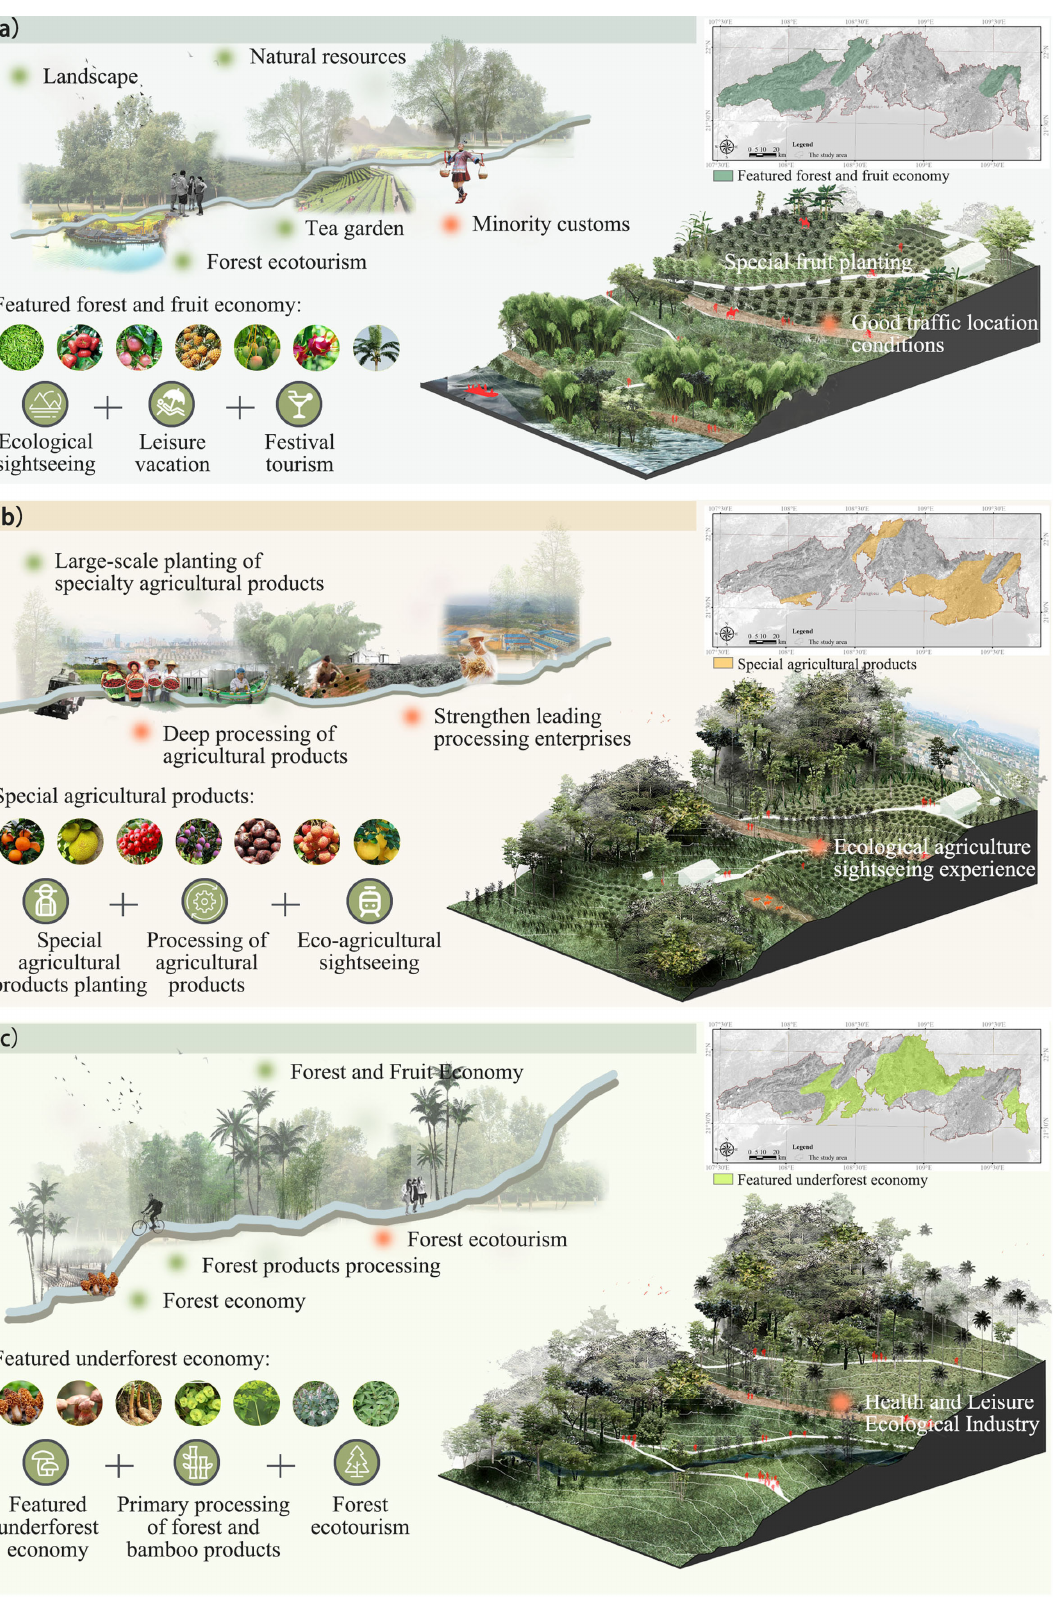
Figure 6. Landscape planning for different local economic development models of the study area. ( a ) featured forest and fruit economy, ( b ) special agricultural products, and ( c ) featured under-forest economy.